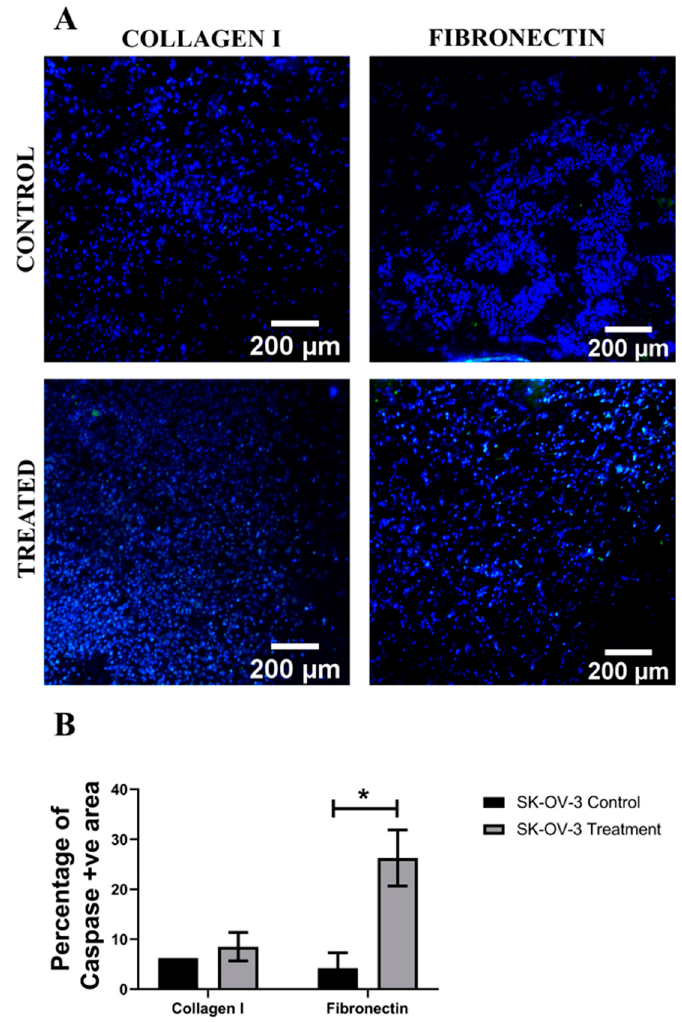
Figure 10. Effect of the chemotherapeutic Cisplatin on the apoptosis of SK-OV-3 cells grown in PU scaffolds of various protein coatings, 24 h post-treatment ( A ): Representative images for caspase 3/7 (apoptosis)–DAPI (green–blue) staining in collagen I- and fibronectin-coated treated and untreated (control) SK-OV-3 polymeric scaffolds. ( B ) Image analysis-based quantification of apoptotic (green) image areas for SK-OV-3 cells grown in collagen I and fibronectin coated polymeric scaffolds. Scale bar = 200 μ m. Quantitative data represent mean ± SEM for multiple images ( ≥ 3) and multiple scaffolds ( ≥ 3). * p ≤ 0.05 .